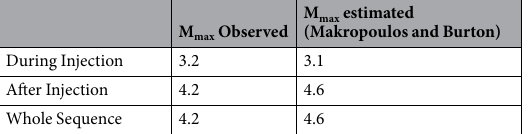
Table 5. Observed maximum magnitude and estimated maximum magnitude by Makropoulos and Burton approach 29 for each analyzed